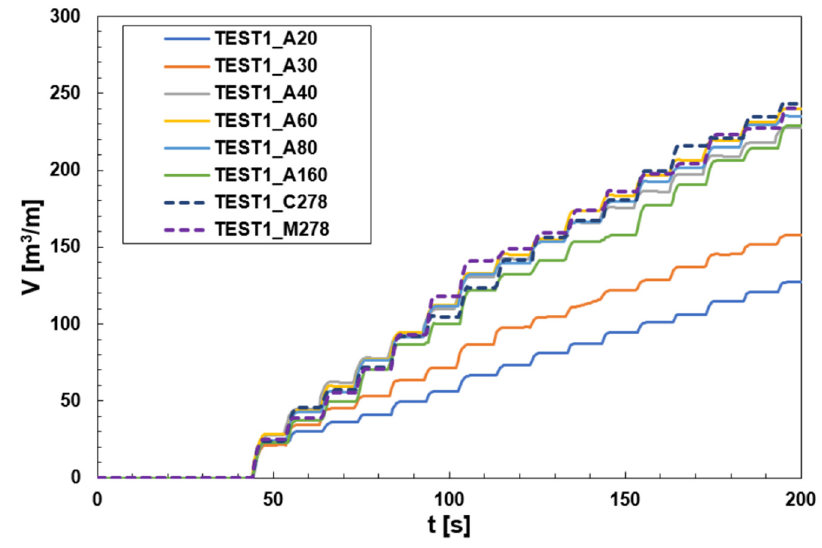
Figure 3. Cumulative overtopping volume curves for different grid sizes